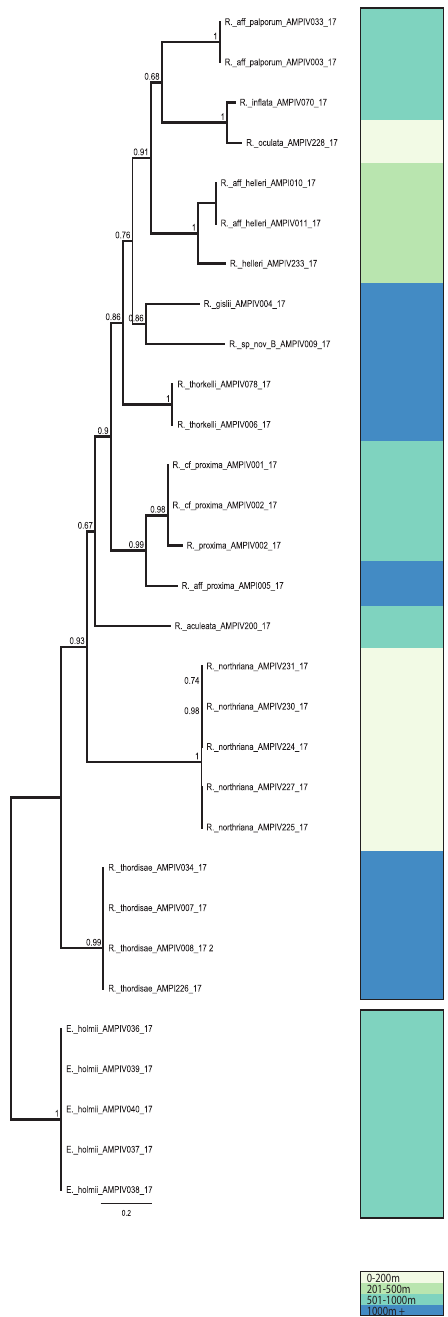
Figure 2. 16S gene tree calculated as in Fig. 1- Rhachotropis samples collected during IceAGE (details Sup- plementary Table 1). Clades are coloured for depth strata for sampling: 0–200 m light grey, 201–500 m light green, 501–1000 m turquoise, 1000+ m